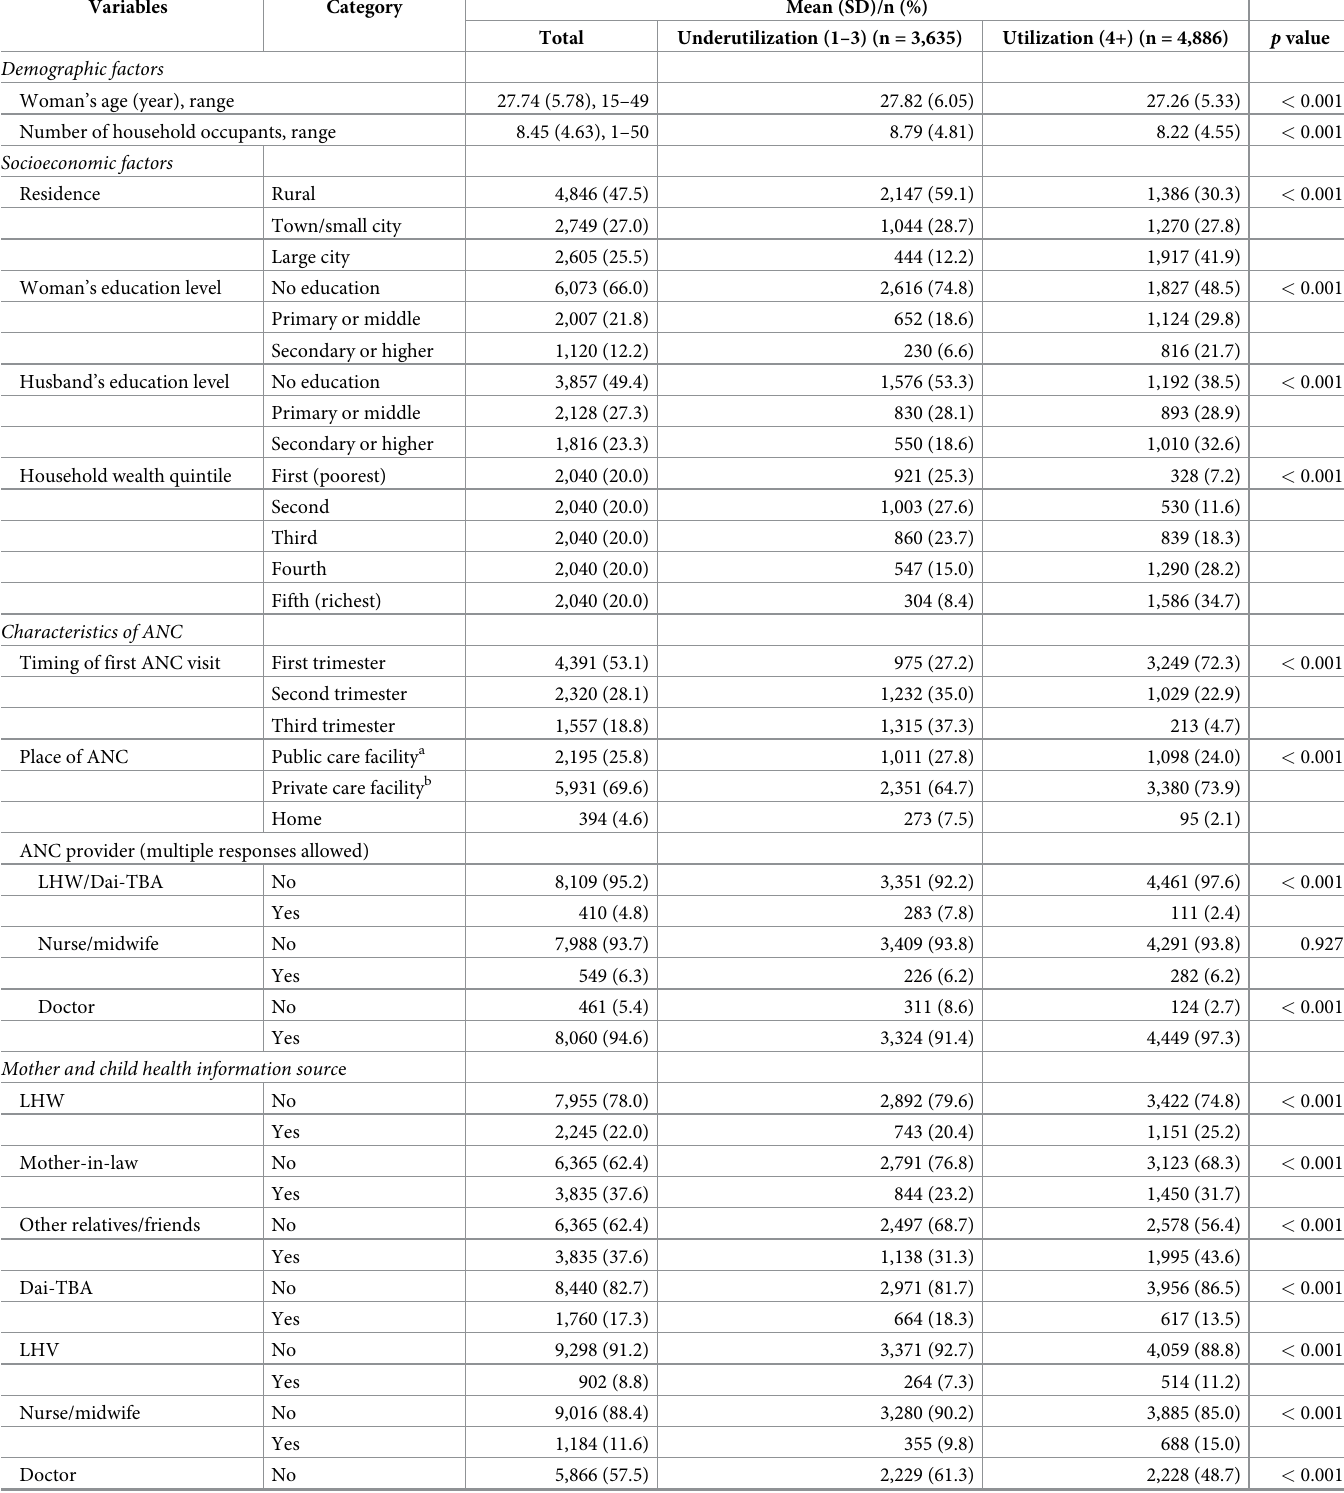
Table 1. Characteristics of survey respondents (n =